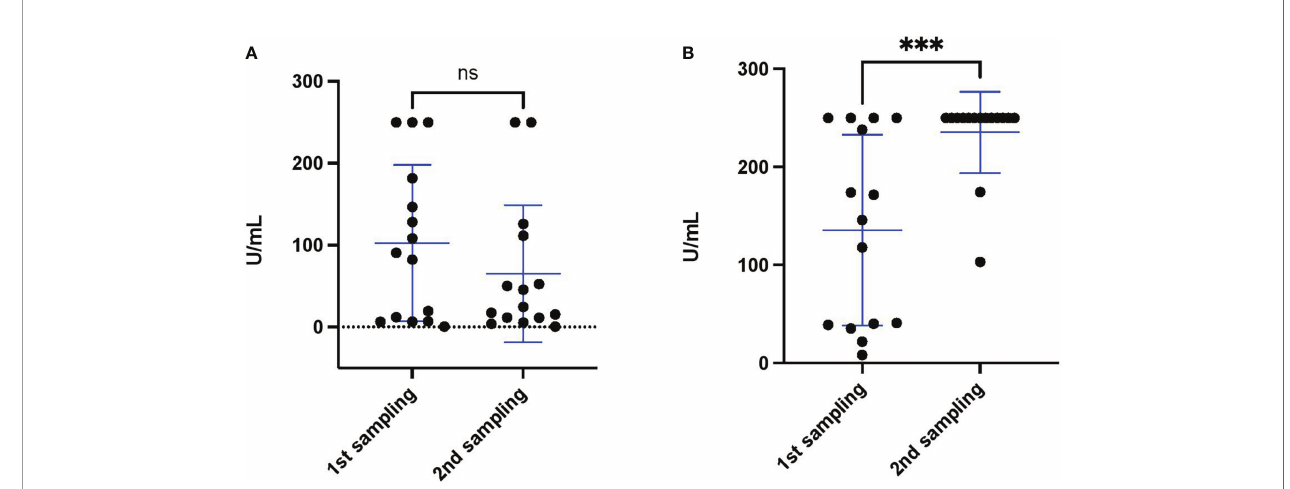
FIGURE 3 | S antibody levels monitored after double vaccination with the Sinopharm vaccine and the P fi zer/BioNtech vaccine booster. (A) S antibody levels of 15 healthy individuals after double Sinopharm vaccination (1st sampling) and subsequent antibody level monitoring (2nd sampling). (B) S antibody levels of 15 healthy individuals after double Sinopharm vaccination (1st sampling) (different individuals from panel A) and after P fi zer/BioNtech booster (2nd sampling). Differences between groups were assessed by Mann Whitney test. The asterisk indicate ***p value < 0.001. ns, not signi fi